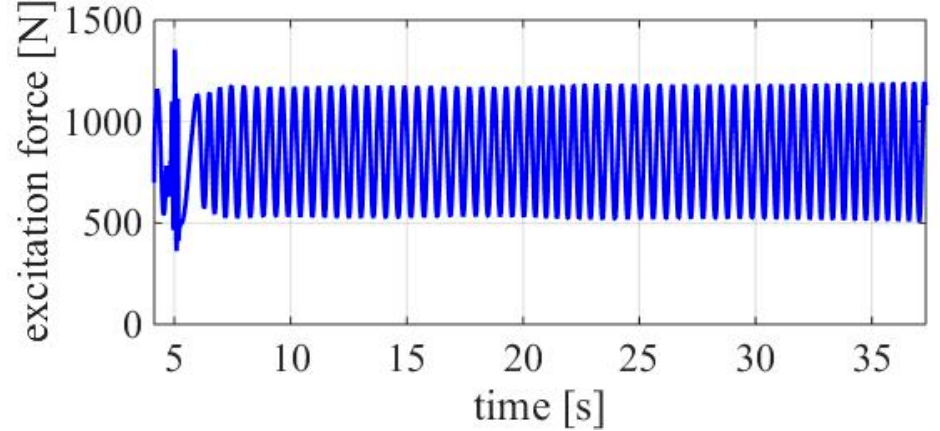
Figure 7. The time history of a representative single pedestrian-induced load in the vertical (Z) direction. The pedestrian is the one who arrives at 4.14 s and stops walking at 37.32 s when the simulation ends.